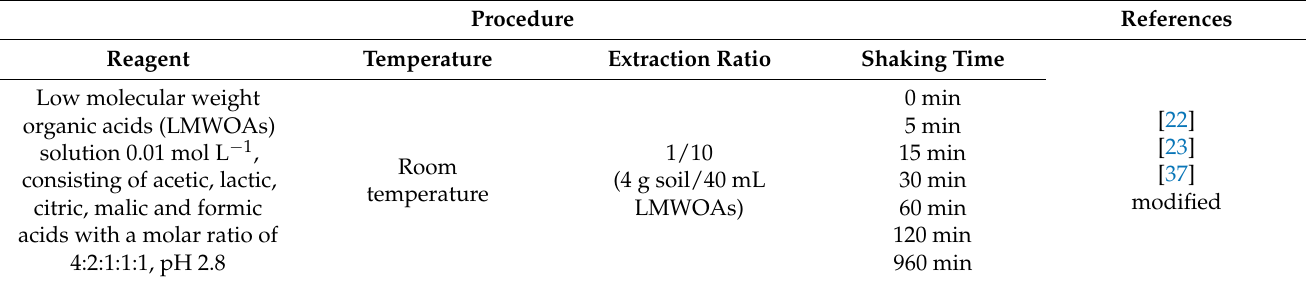
Table 2. Extraction protocol adapted for the study of PTE behavior in rhizospheric